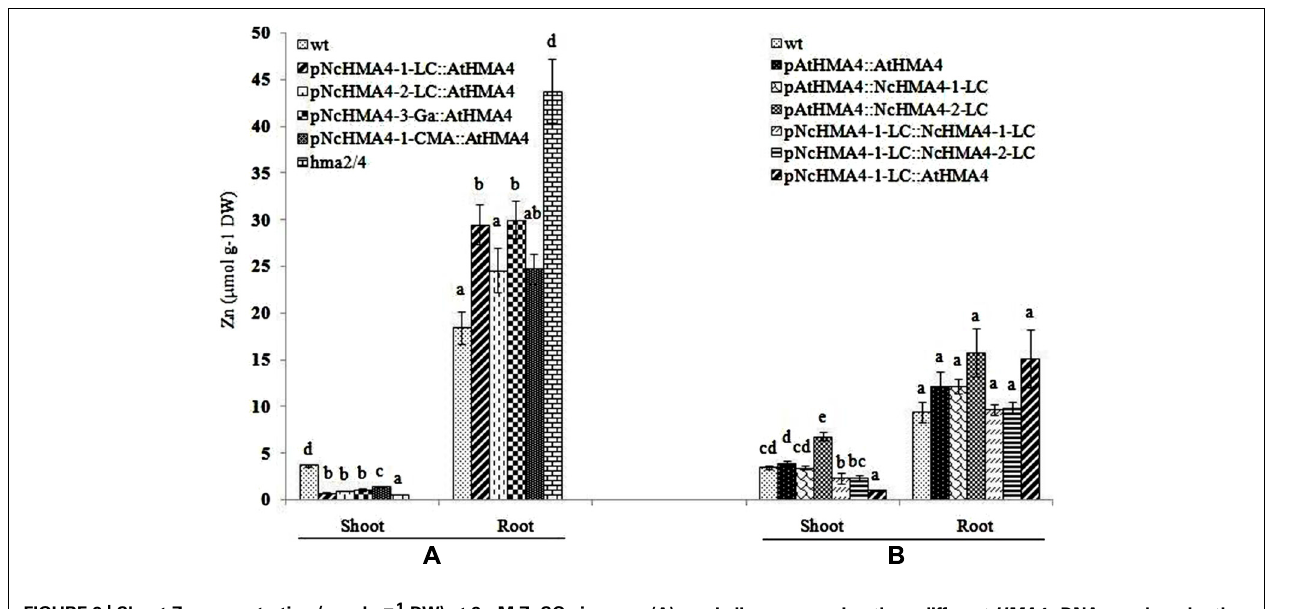
(A), or six lines expressing three different HMA4 cDNAs, each under the AtHMA4 and the NcHMA4-1-LC promoter (B) . Significant differences ( P < 0.05) between means are indicated, separately for both shoots and roots, by different superscripted letters.